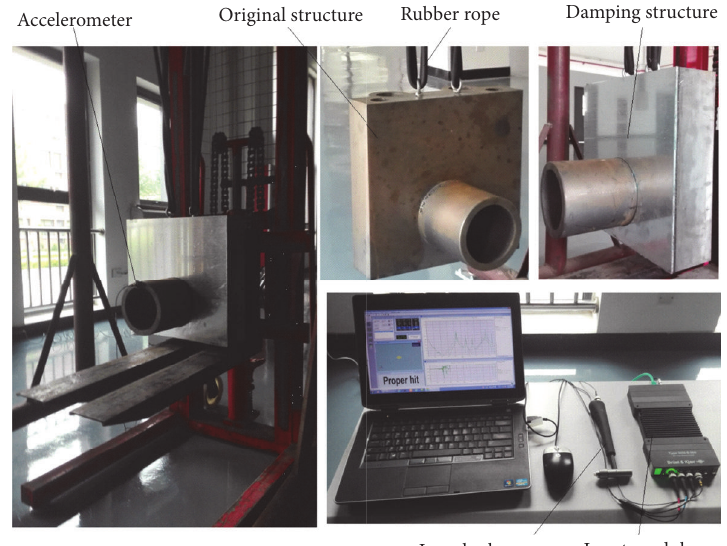
Figure 13: Experiment setup of the